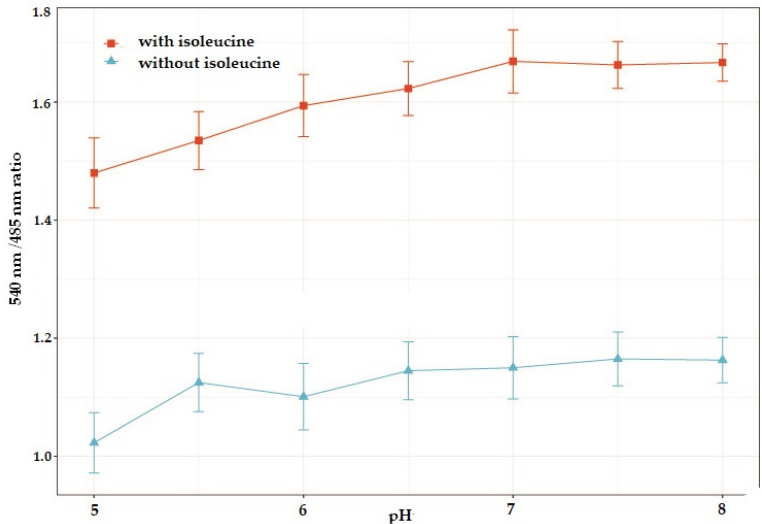
Figure 5. pH stability analysis of the GEII nanosensor. Measurement of the FRET ratio change of purified GEII nanosensor protein at different pH of the buffer solution in the absence, and presence of 10 mM isoleucine. Sensor protein concentration was kept at 0.20 mg/mL. All readings are averages of 3 independent experiment runs with the error bars indicating standard deviation.